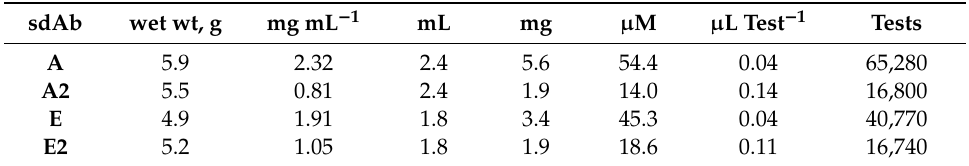
Table 1. Unoptimized first pass yields of the sdAb–APEX2 fusions following periplasmic expression and purification from a handful of grams of wet weight E. coli reveal the potential for tens of thousands of small volume staining tests based on 200 µ L volumes of 10 nM.